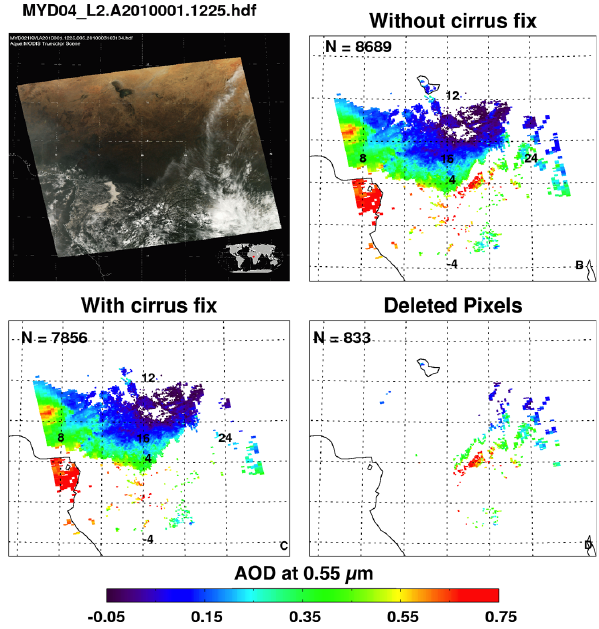
Fig. 9. MODIS-Aqua granule over central Africa, observed on 1 January 2010 at 12:25UTC. Top left: true-color image constructed from red/green/blue channels [modis- atmos.gsfc.nasa.gov). (b and c) Retrieved, high quality (QAC=3 over land, QAC ≥ 1 over water) AOD at 0.55µm before/after the cirrus bug fix. (d) Pixels that have been deleted over land as a result of degraded